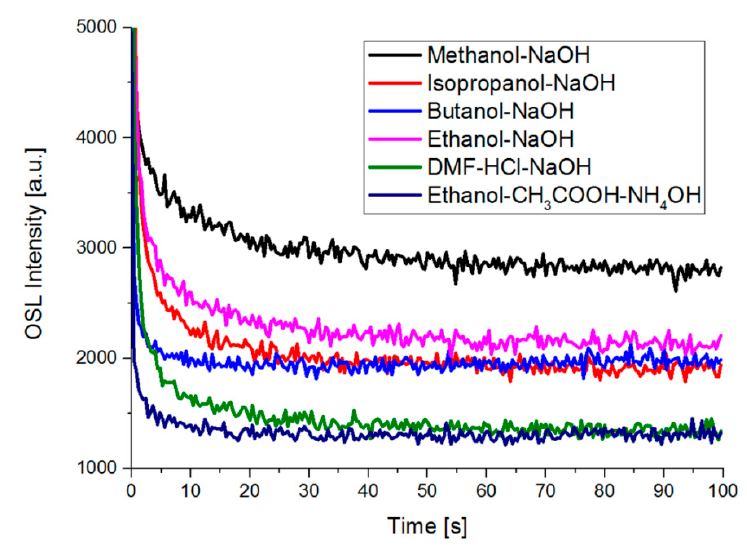
Figure 8. OSL spectra of gel samples.